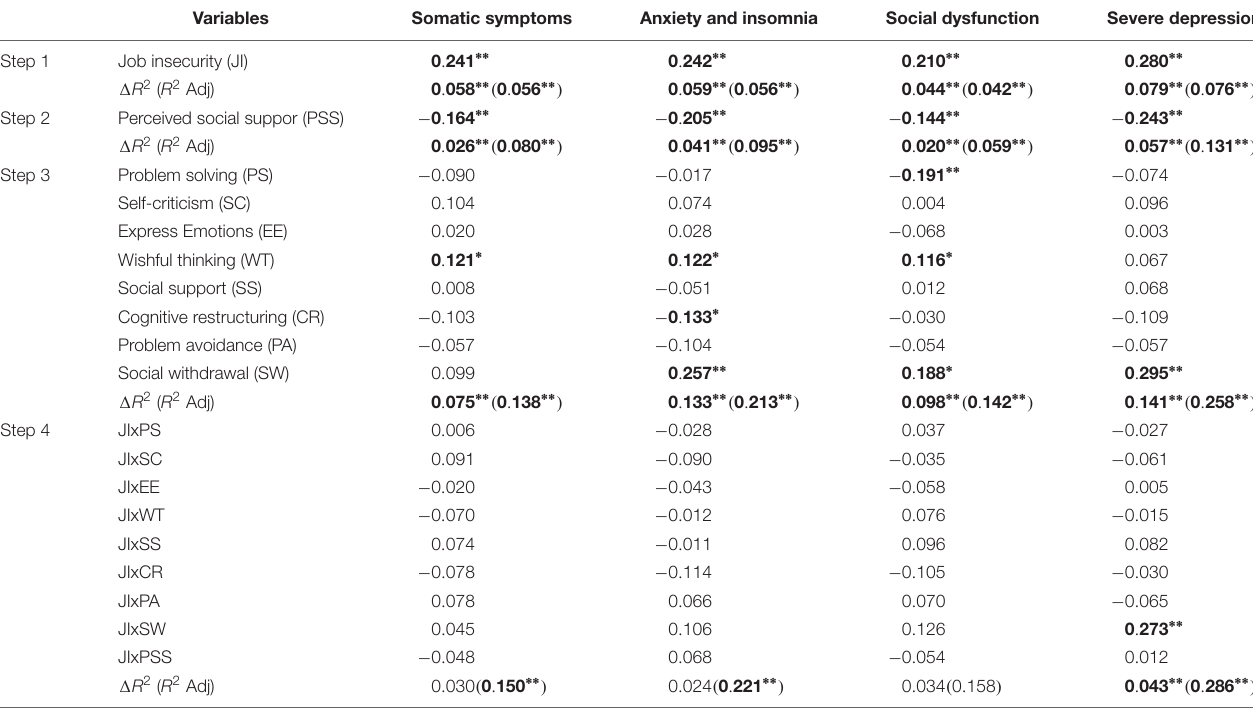
TABLE 3 | Results of hierarchical regression analysis for job insecurity, coping strategies and GHQ-28 subscales for men (standardised coefficients). Variables Somatic symptoms Anxiety and insomnia Social dysfunction Severe